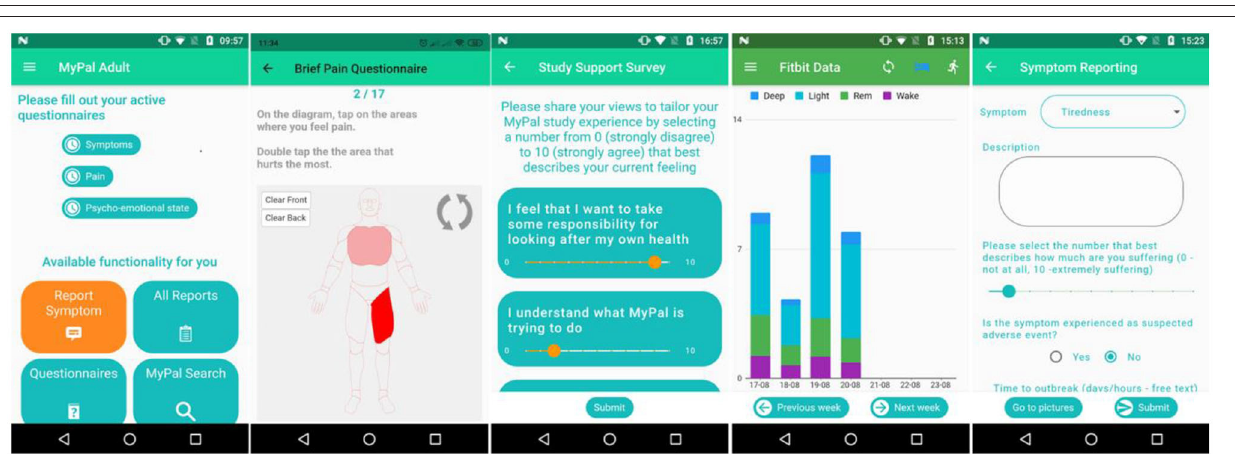
FIGURE 2 | MyPal software architecture.